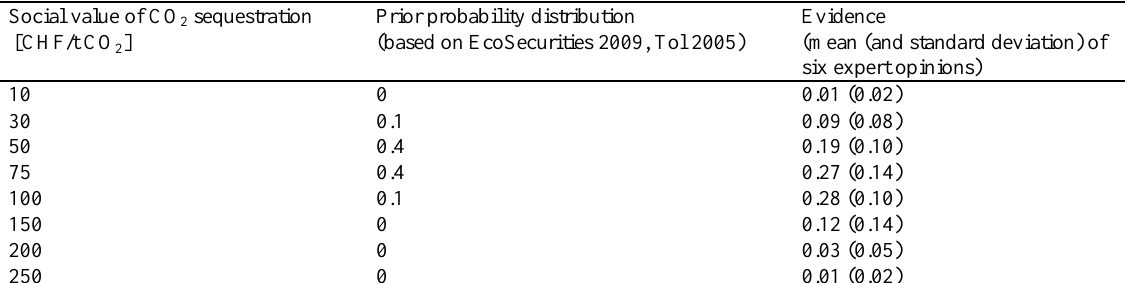
Table A3.2. Prior probability distribution of the social value of carbon sequestration and evidence provided by experts. The evidence that was fed into the Bayesian Network was calculated as the mean value of the probability estimates for each state of the node provided by the single experts.